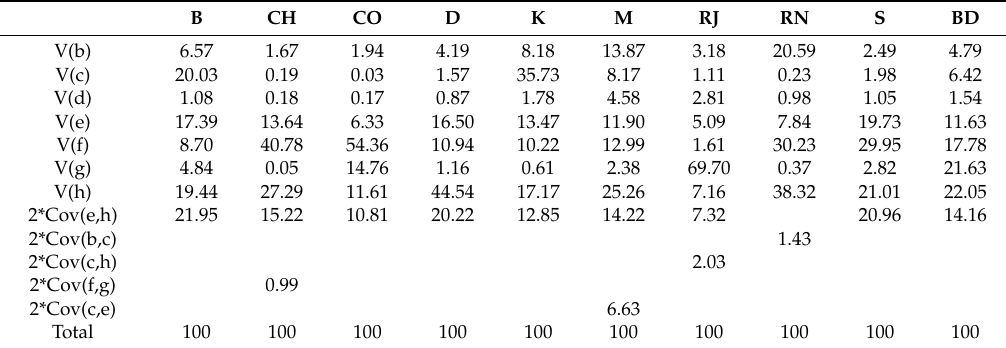
100 100 100 100